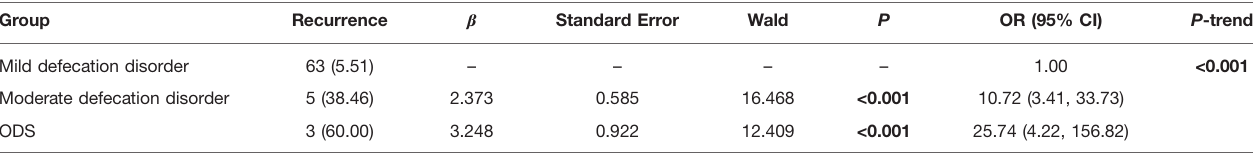
TABLE 6 | Effects of poor defecation habits on hemorrhoid recurrence. Group